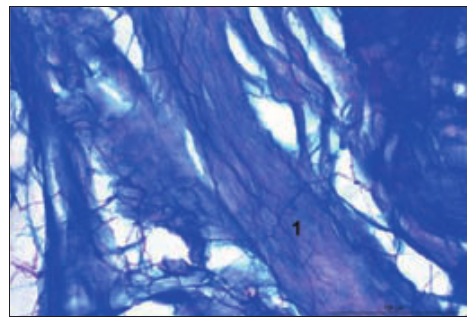
Fig. 8. Longitudinal section of cervix. Pas alcian blue method x